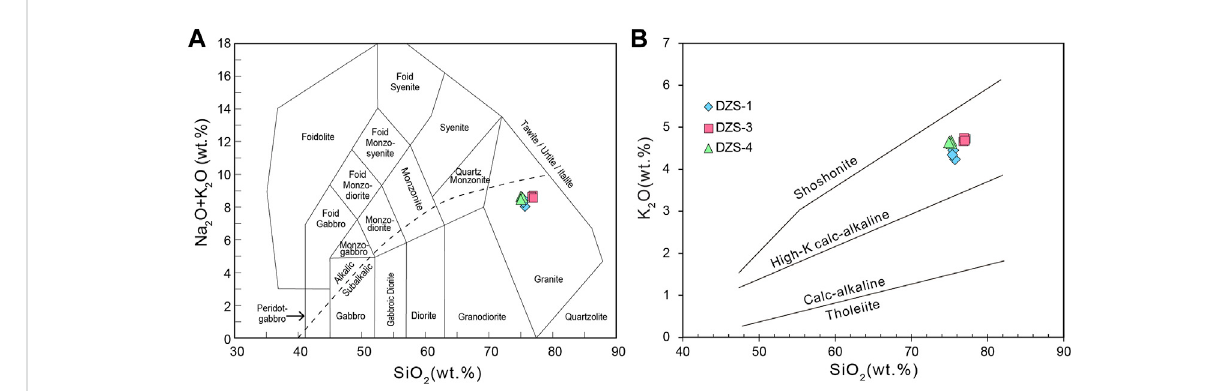
FIGURE 4 Total alkaline vs. SiO 2 (A) and SiO 2 vs. K 2 O (B) diagrams (Peccerillo and Taylor, 1976; Le Bas et al.,